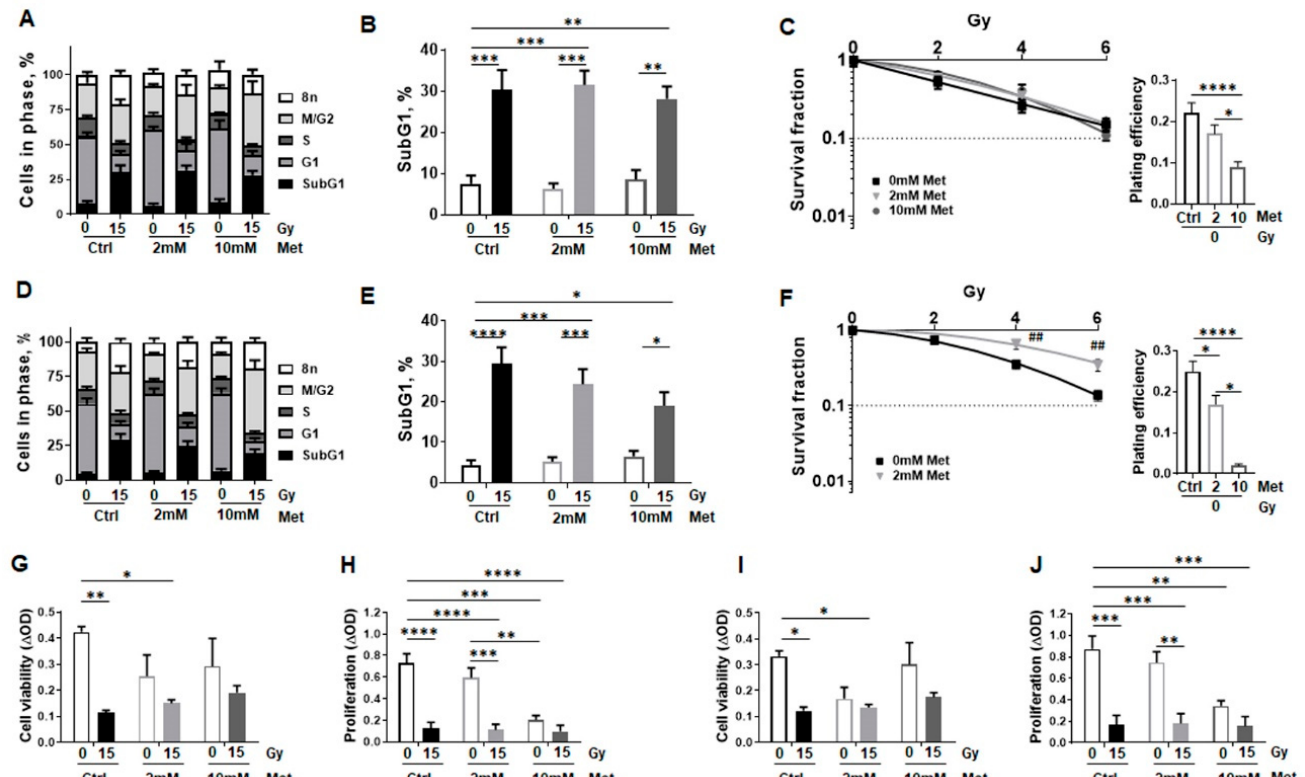
Figure 4. Metformin treatment does not impact on proliferation and survival of normal epithelial lung cell cultures fol- lowing RT. Lung epithelial cell lines derived from normal lung epithelium (BEAS-2B: human bronchial epithelial